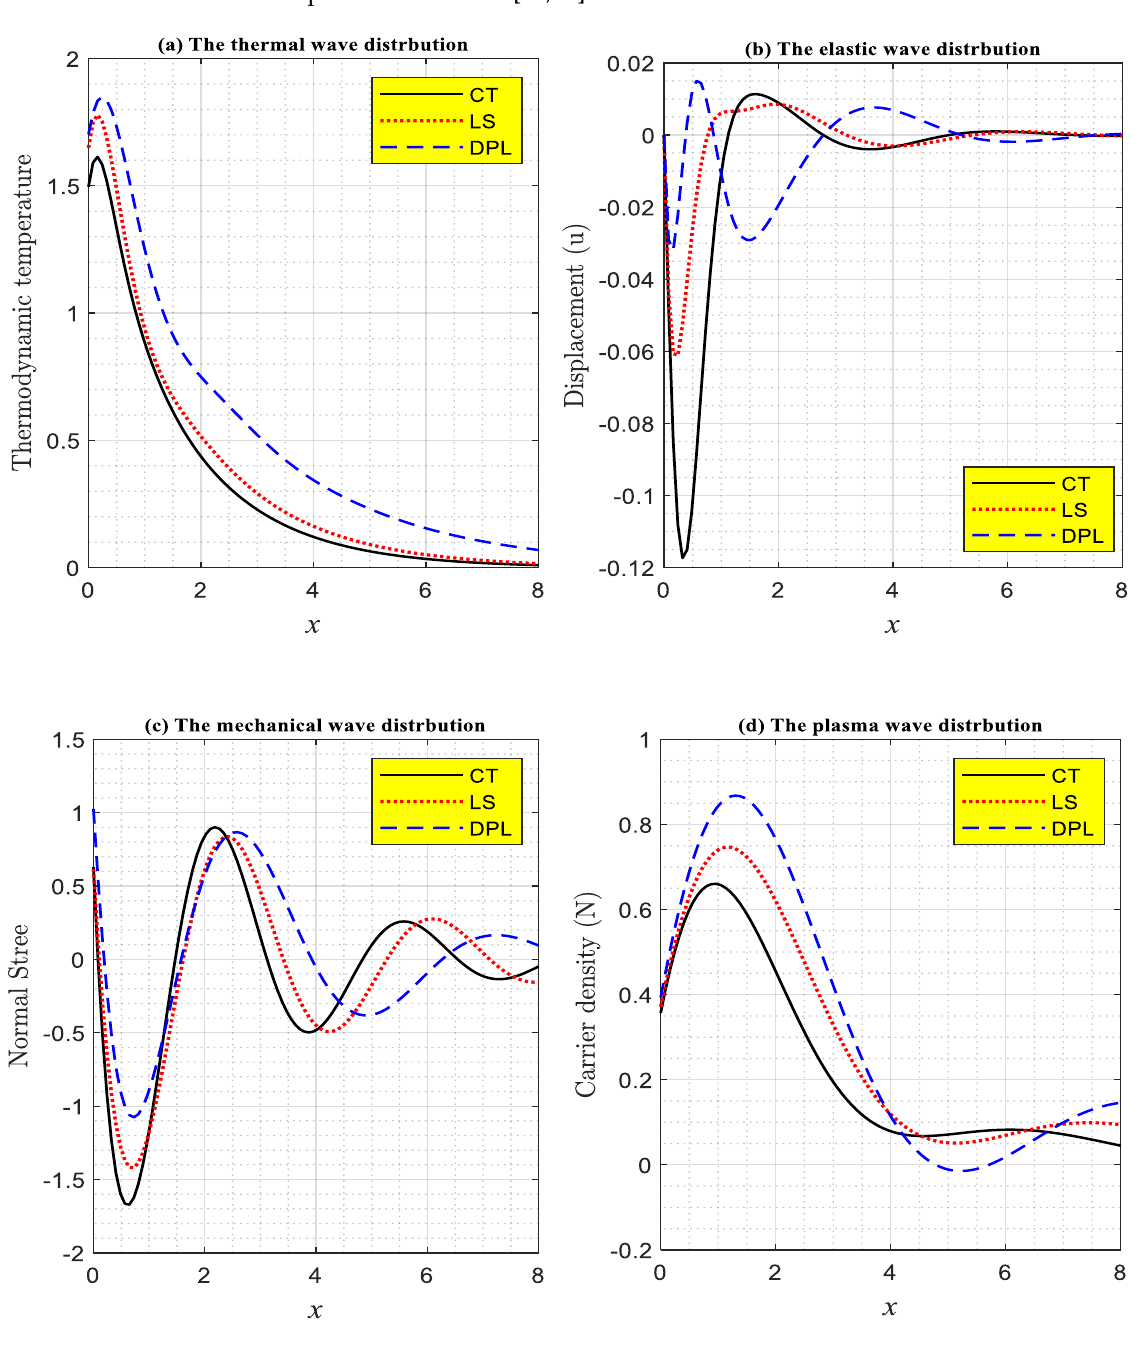
Figure 2. According to the two-temperature theory, the primary field distributions change with horizontal distance at various thermal memory (thermal relaxation durations) under the impact of laser